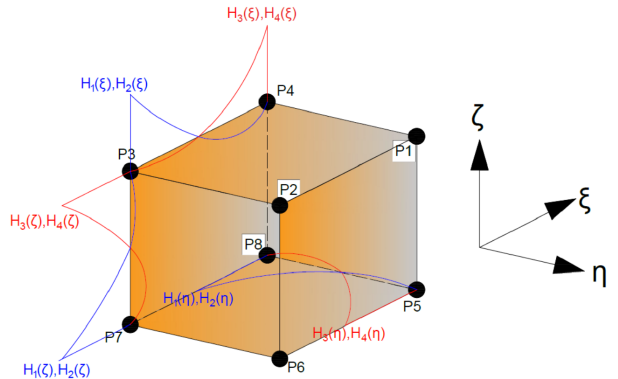
Figure 3. Combination of shape functions for each node